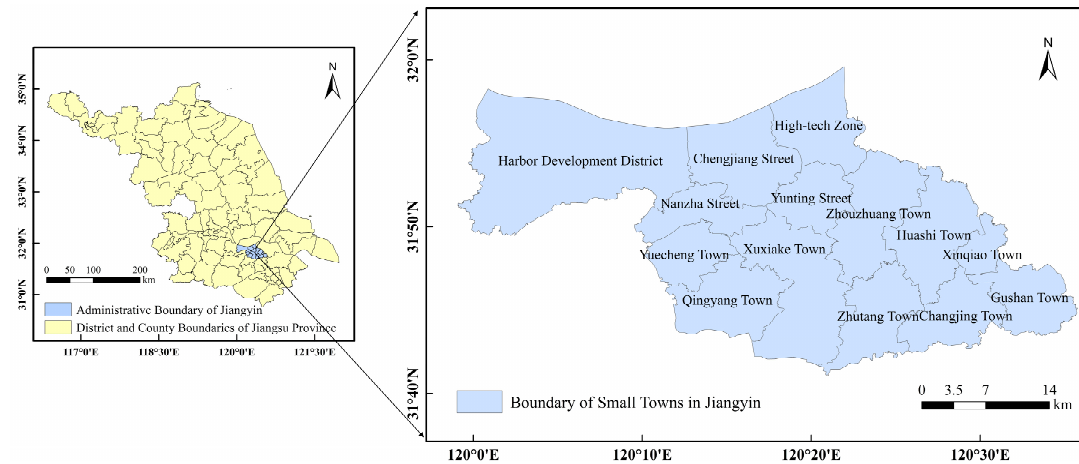
Figure 1. Location of areas covered in Jiangyin